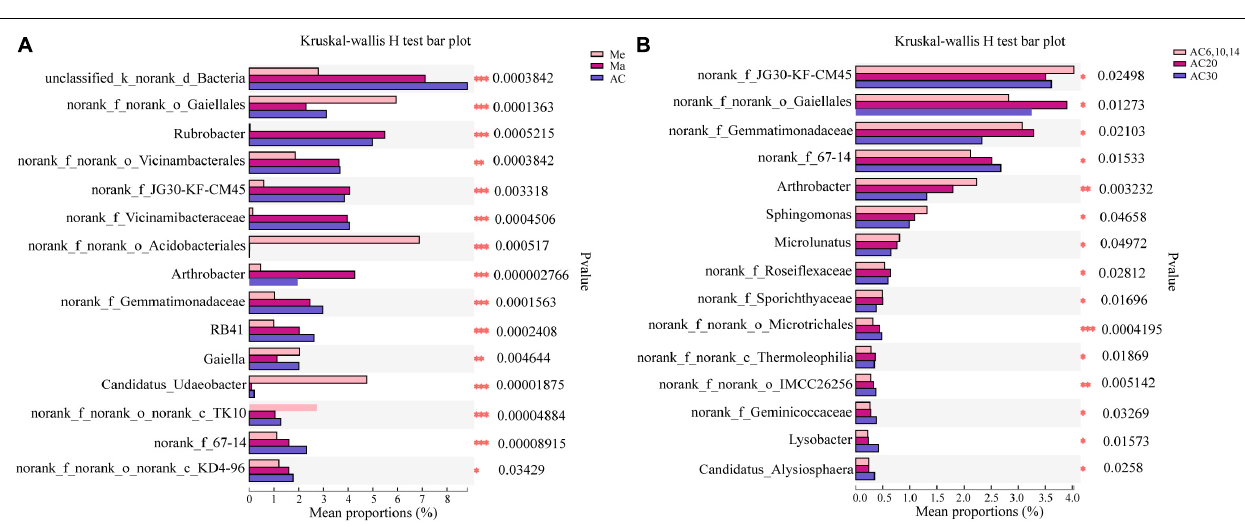
FIGURE 4 | Canonical correspondence analysis (CCA) of bacterial communities changes with the environmental variables.